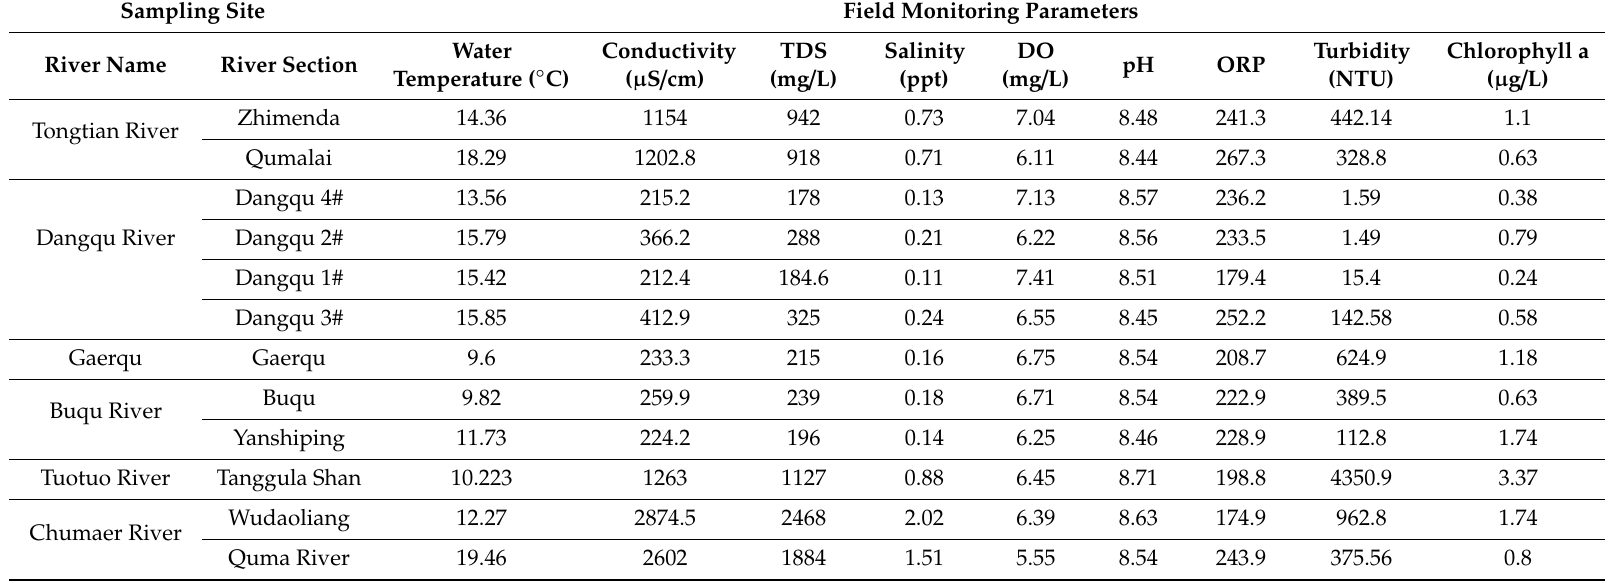
Table 2. Water quality parameters of di ff erent rivers by field monitoring in the SRYR. Sampling